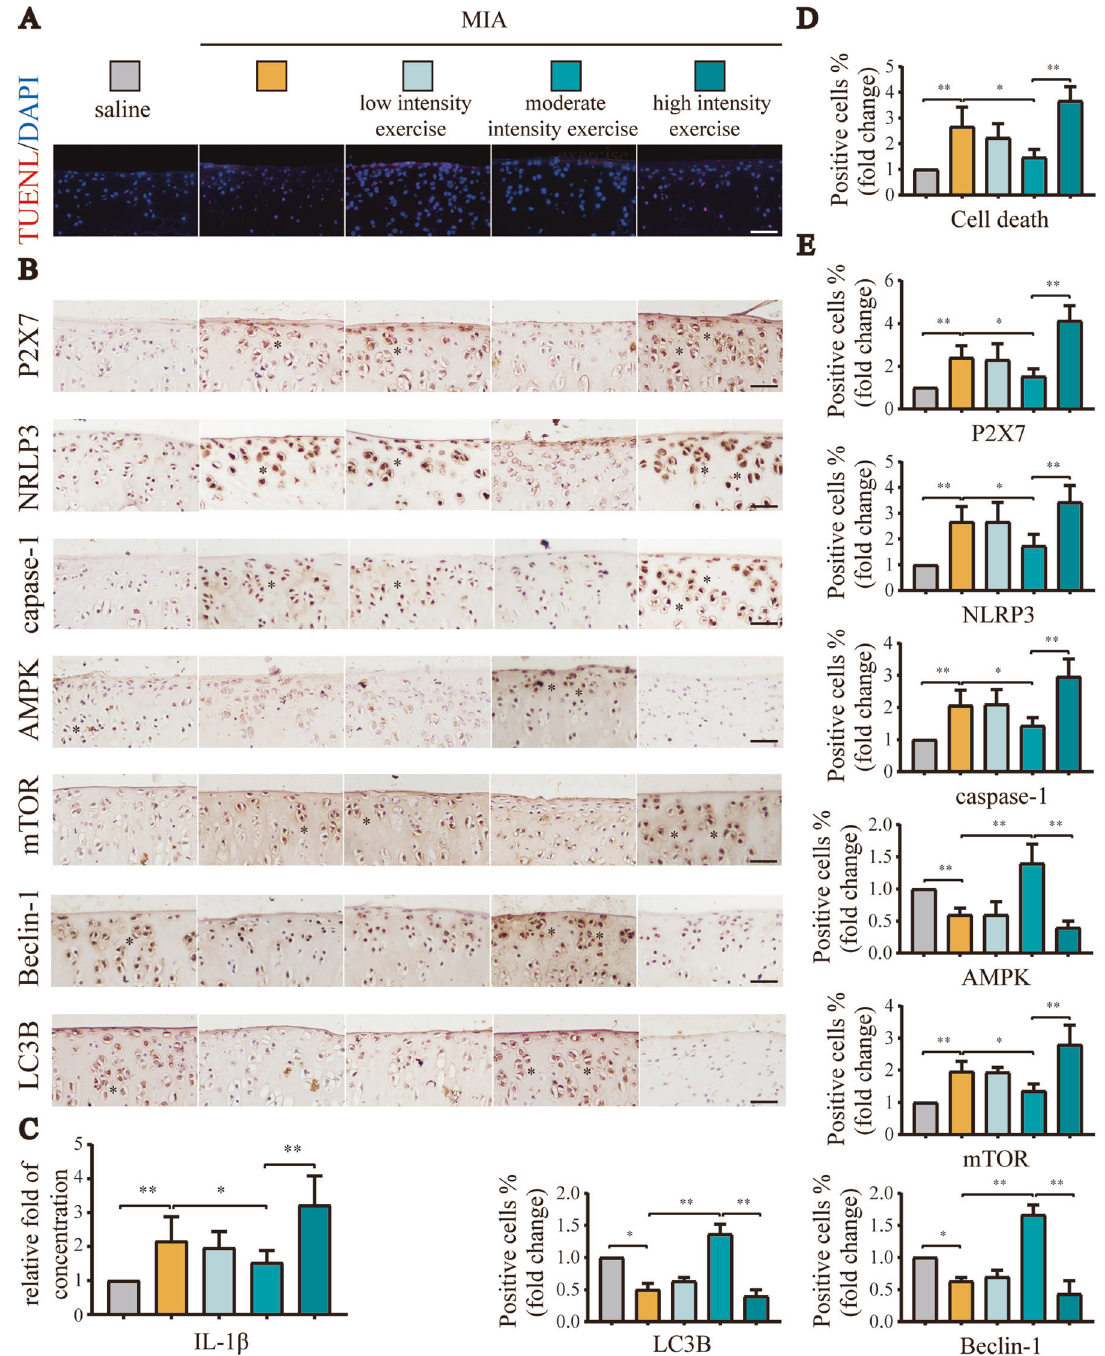
Fig. 1 Moderate-intensity exercise downregulated P2X7, promoted autophagy, and inhibited pyroptosis. We set the following fi ve groups: saline, MIA, MIA + low-intensity exercise, MIA + moderate-intensity exercise, MIA + high-intensity exercise. A total of 50 rats were randomly assigned, with 10 rats in each group. The animal tissues in this part, such as paraf fi n sections and joint cavity lavage fl uid, came from previous experiments of our research group [23]. A TUNEL assays were used to evaluate cell death in tissue sections from each group. Red: dead cells; blue: nuclei stained by DAPI (scale bar: 50 μ m). B IHC was used to evaluate P2X7, NLRP3, caspase-1, mTOR, AMPK, LC3B, and Beclin- 1 expression in tissue sections from each group. Brown: stained cells; blue: hematoxylin-stained nuclei (scale bar: 500 μ m). C ELISA were used to detect IL-1 β content in the articular cavity lavage fl uid from each group. D Statistical data for cell death in TUNEL assays. E Statistical data for stained cells in IHC analysis. The * in the histochemical images represents the positively stained cells. Data are presented as means ± standard deviations of at least three independent experiments. * p < 0.05, ** p <